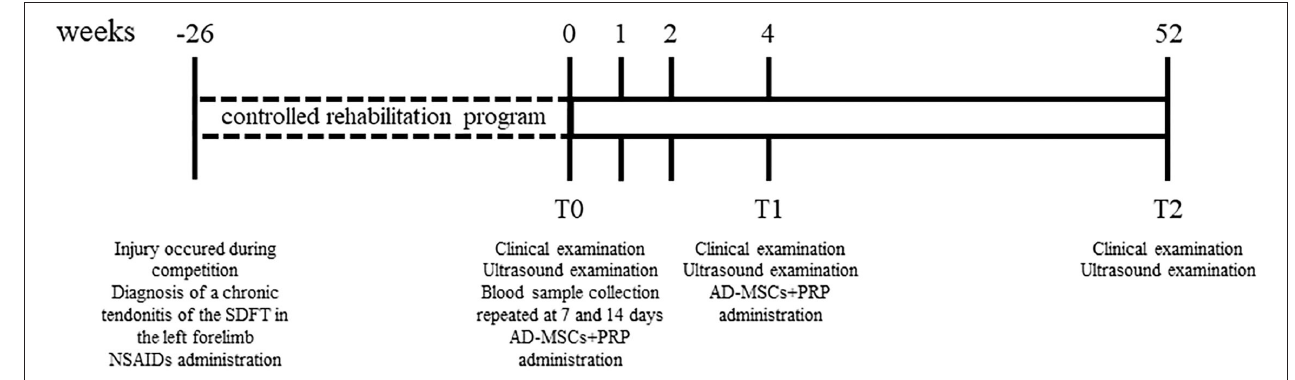
Diagnostic Imaging: Ultrasound